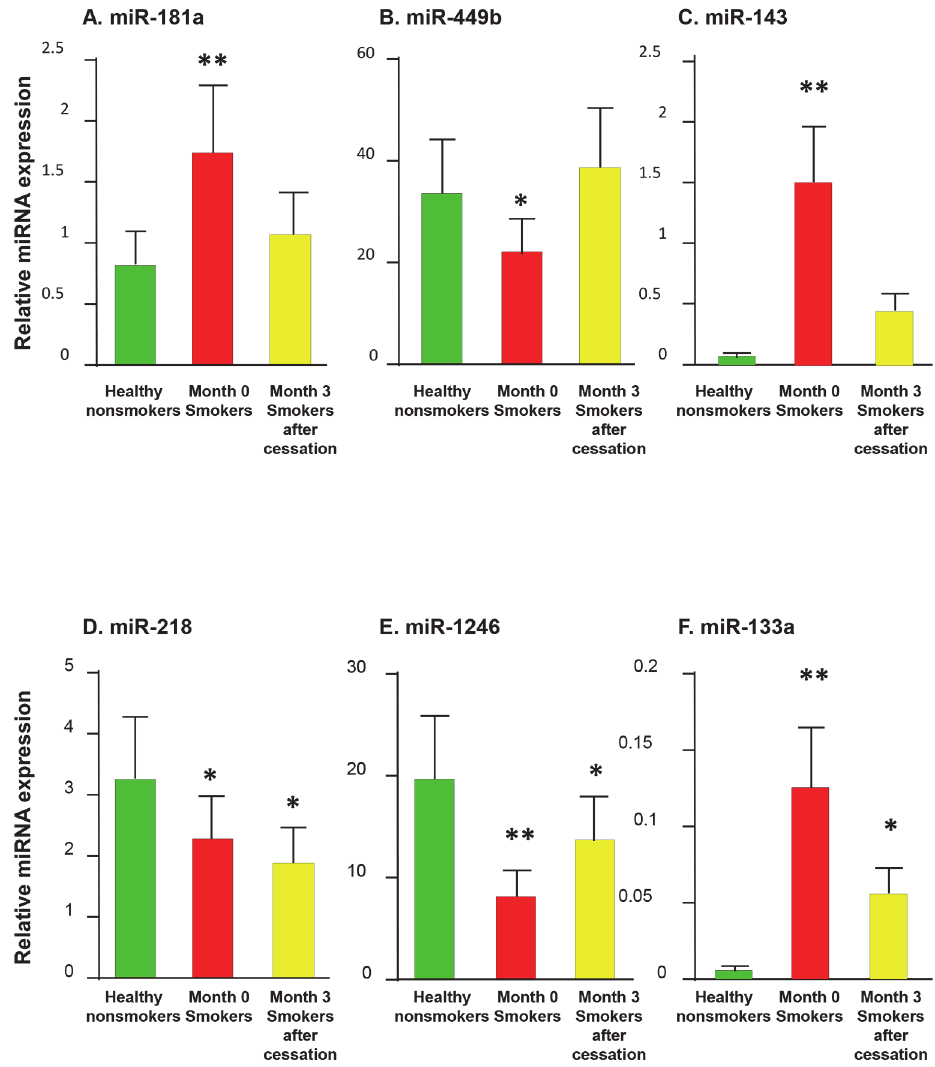
Fig 3. TaqMan quantitative PCR validation of smoking cessation reversible and smoking cessation persistent miRNAs in the SAE. MicroRNA let-7a was used as endogenous control. Error bars indicate standard error, and p values (compared with nonsmokers) were determined using Mann-Whitney test. * , p < 0.05; ** , p < 0.01. A-C: Validation of reversible miRNAs after smoking cessation. A: miR-181a; B: miR- 449b; and C: miR-143. D-F: Validation of persistent miRNAs after smoking cessation. D: miR-218; E: miR- 1246; and F: